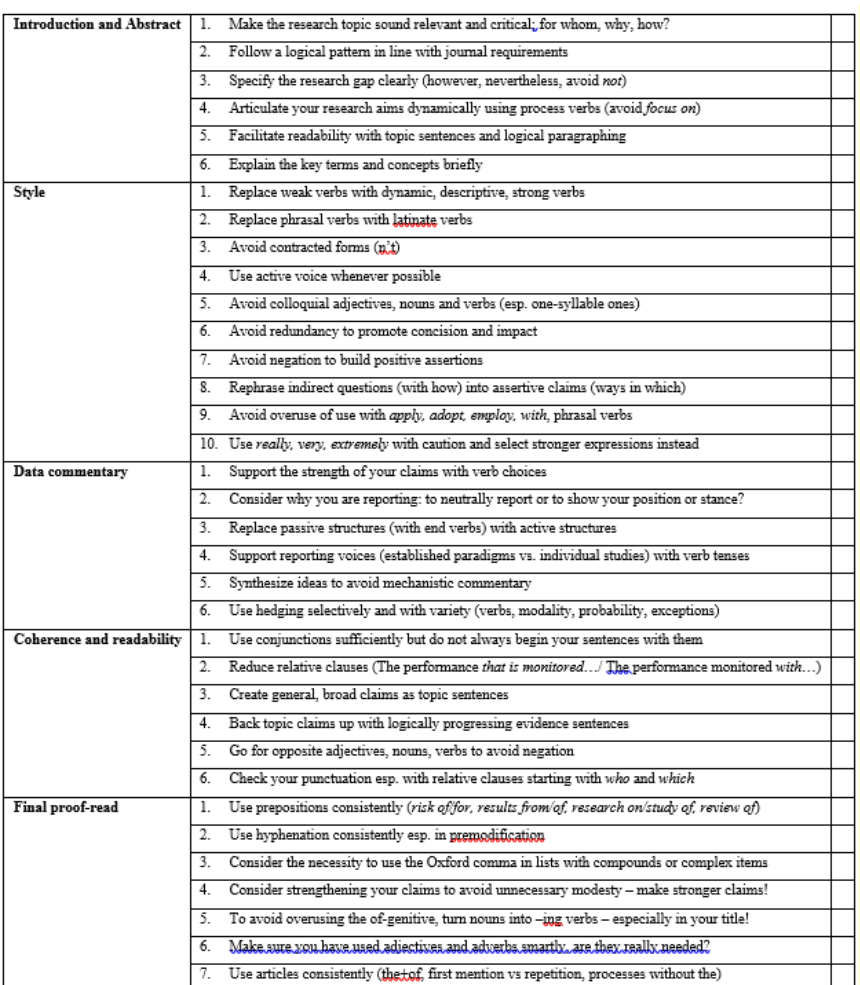
Table 1. Self-study